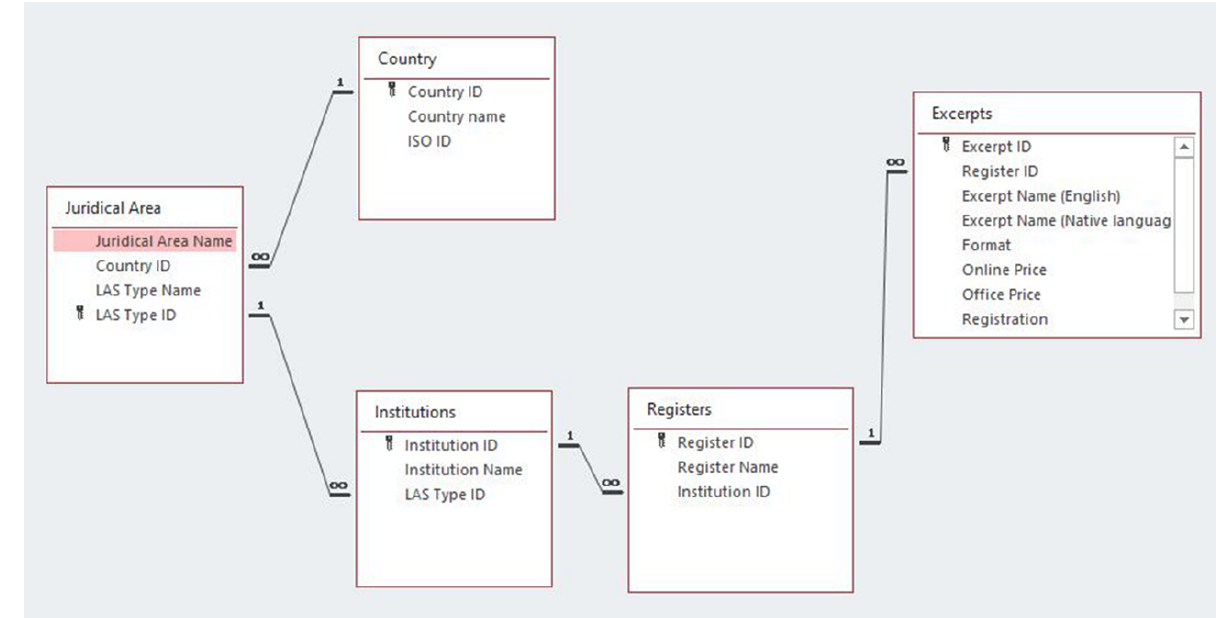
Figure 2. LAS Data Dissemination Database Model. Source: Own compilation.